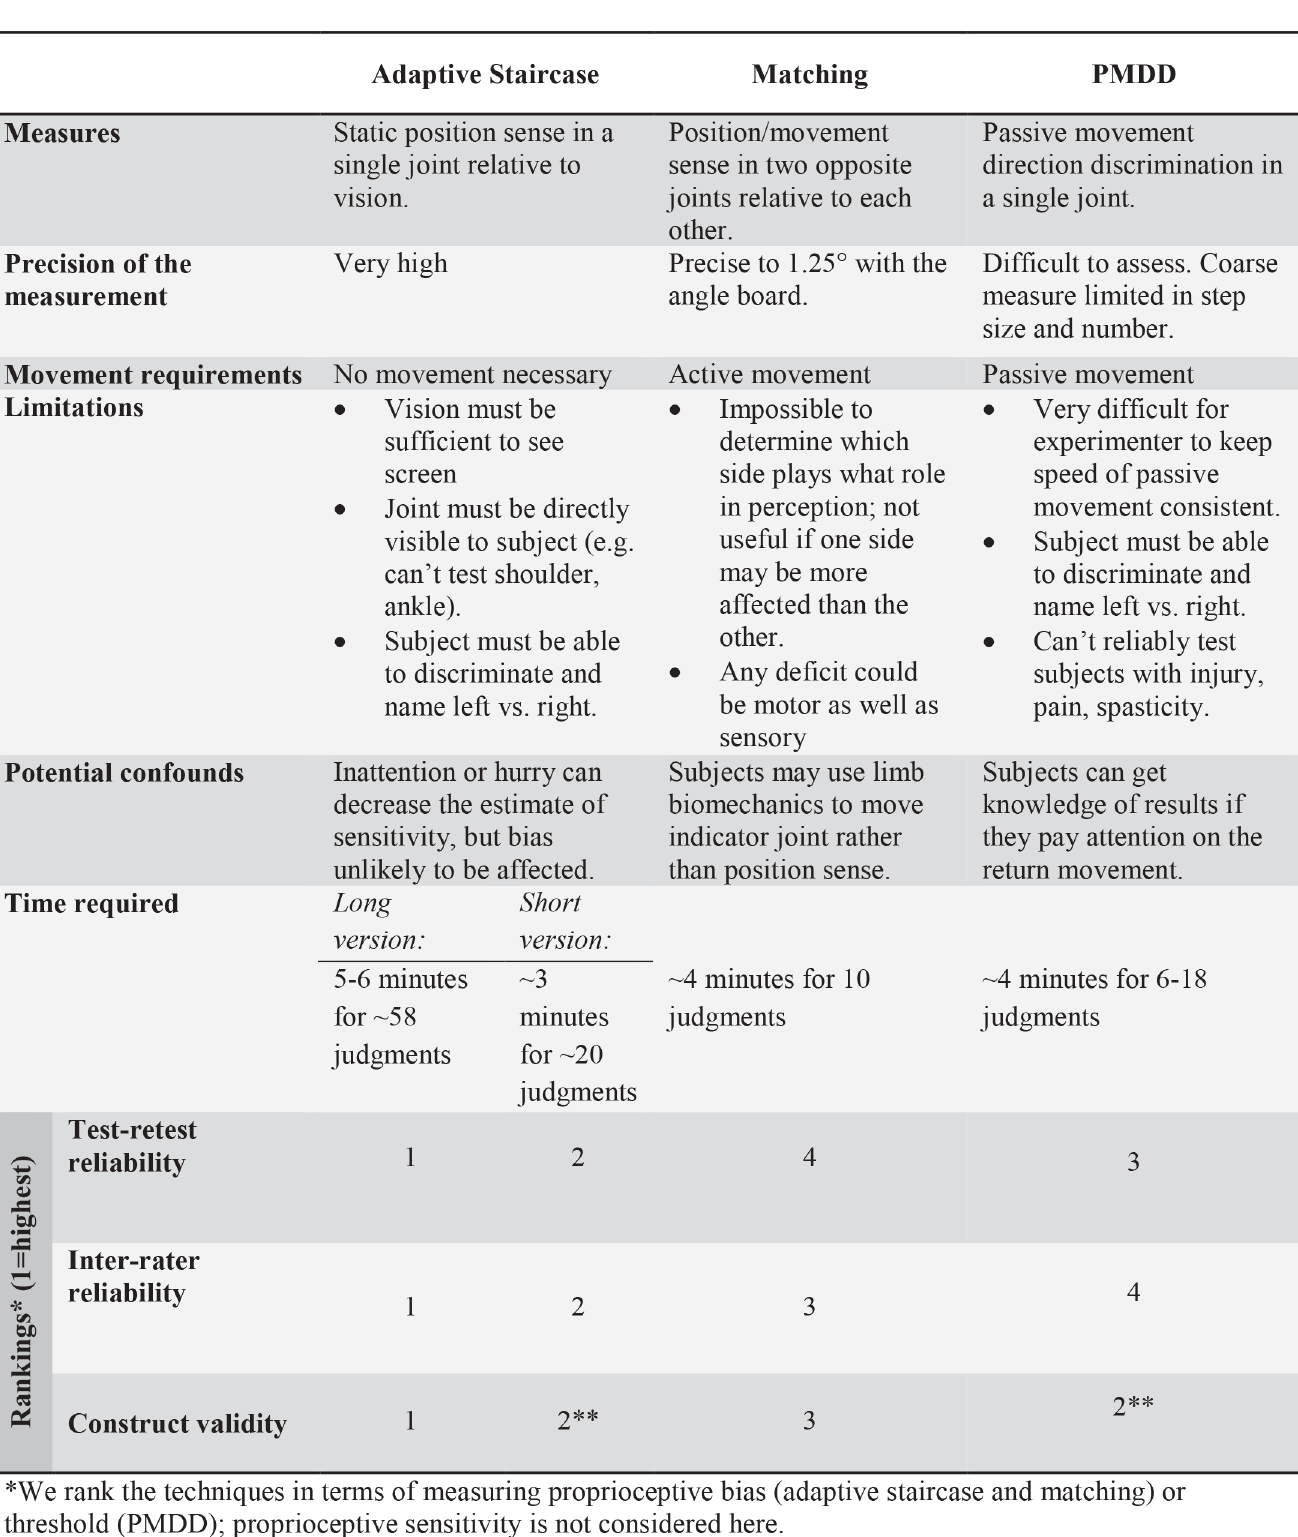
Fig 7. Comparison of the three measurement